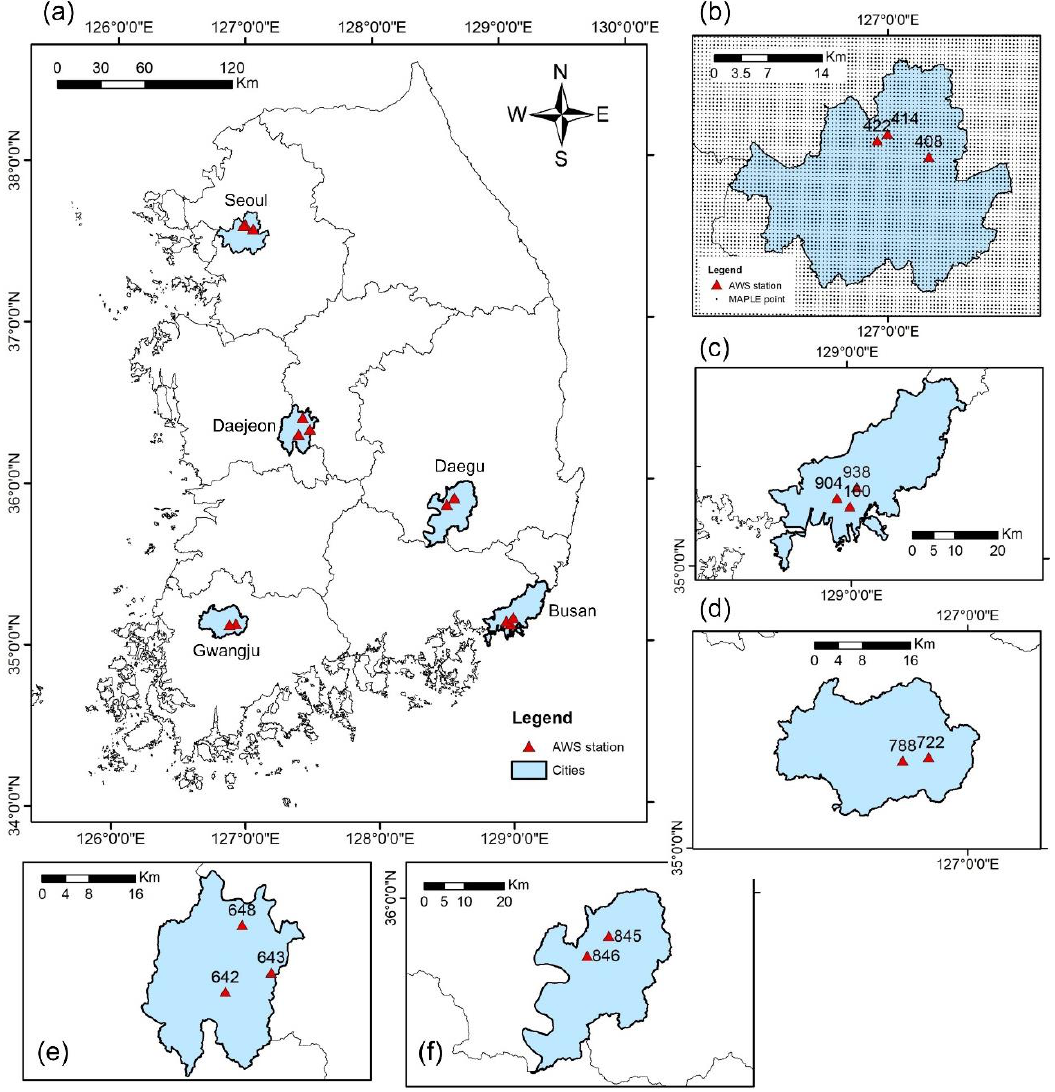
Figure 1. ( a ) Location of the cities in Korean Peninsula and the rain gauges of the Automatic Weather System (AWS). ( b ) Seoul city and MAPLE data points. ( c ) Busan city. ( d ) Gwangju city. ( e ) Daejeon city. ( f ) Daegu city.